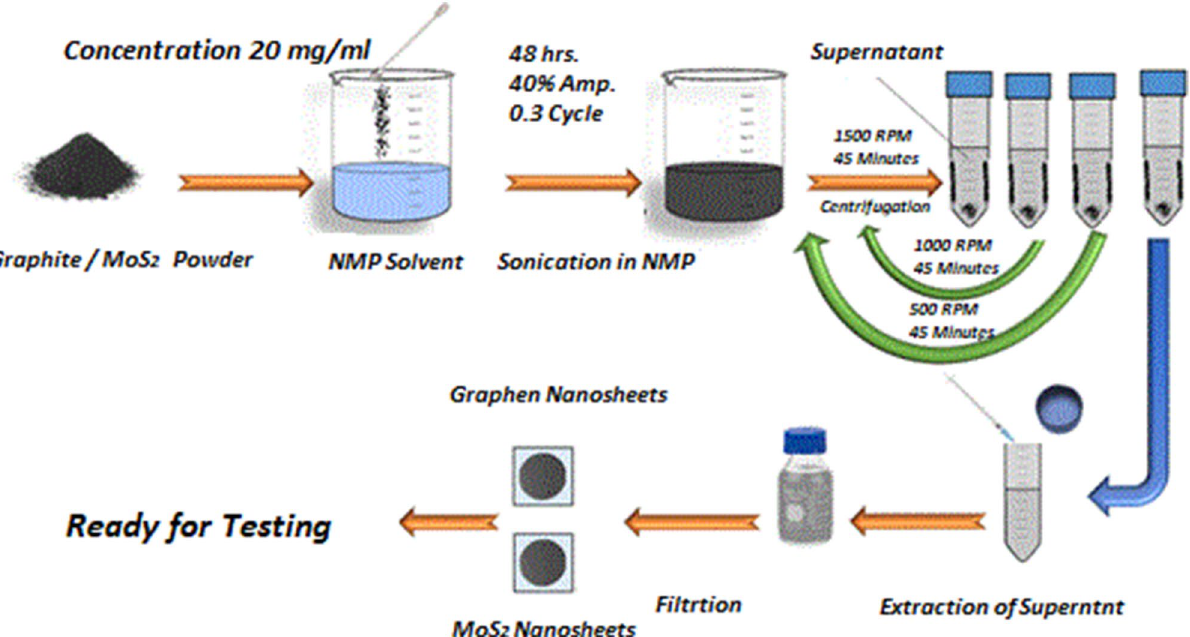
Figure 1. Schematic representation of Liquid Phase Exfoliation (LPE) method showing exfoliation of graphene and MoS 2 powder at 500 and 1000